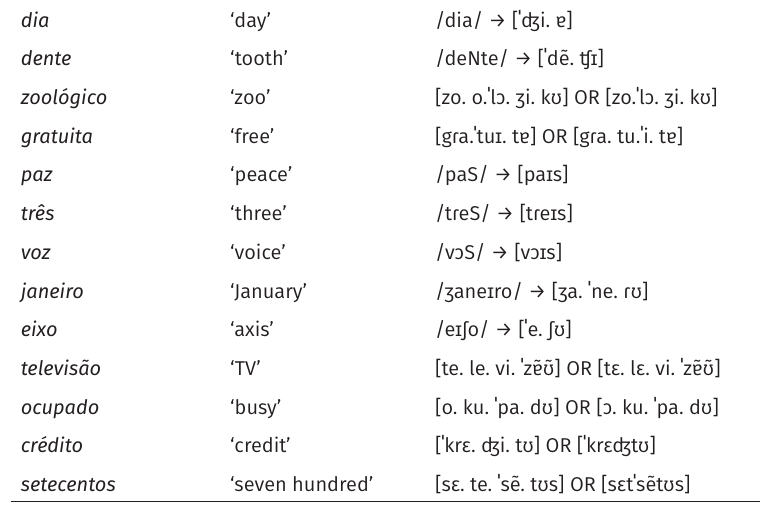
Table 4: Examples of explicit pronunciation modeling included in the Lexicon.